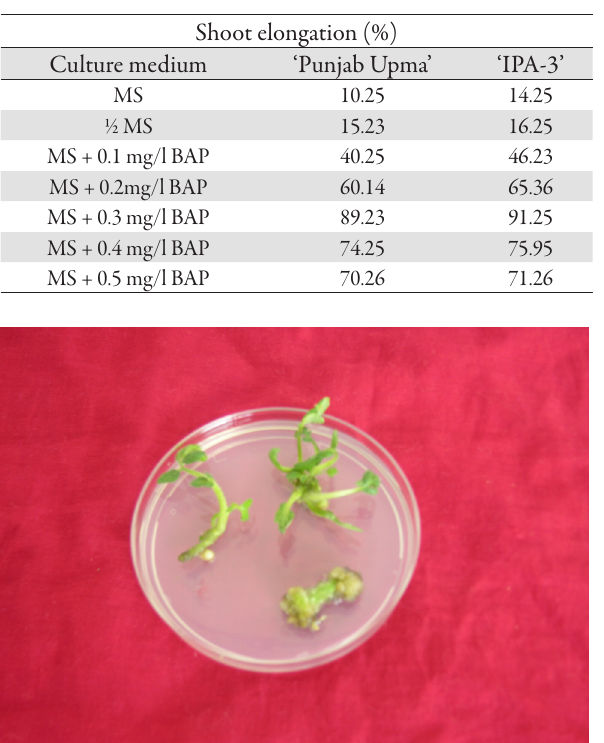
Tab. 3. Per cent shoot elongation in two genotypes of tomato ‘Punjab Upma’ and ‘IPA-3’ on different culture media